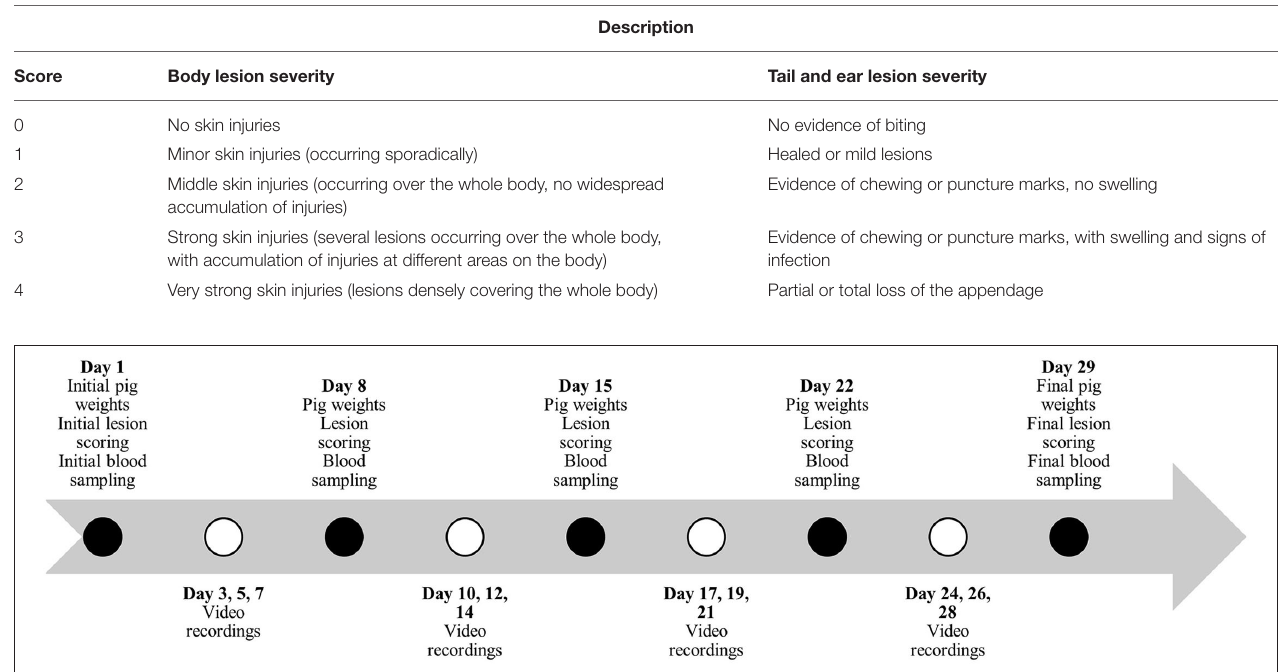
TABLE 2 | Tail, ear, and body lesion severity score reference sheet used for study #1 and study #2. Adapted from Kritas and Morrison (27).